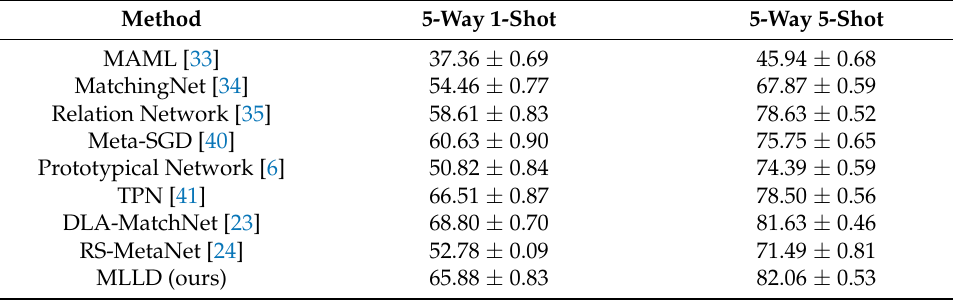
Table 4. Classification accuracy on the NWPU-RESISC45